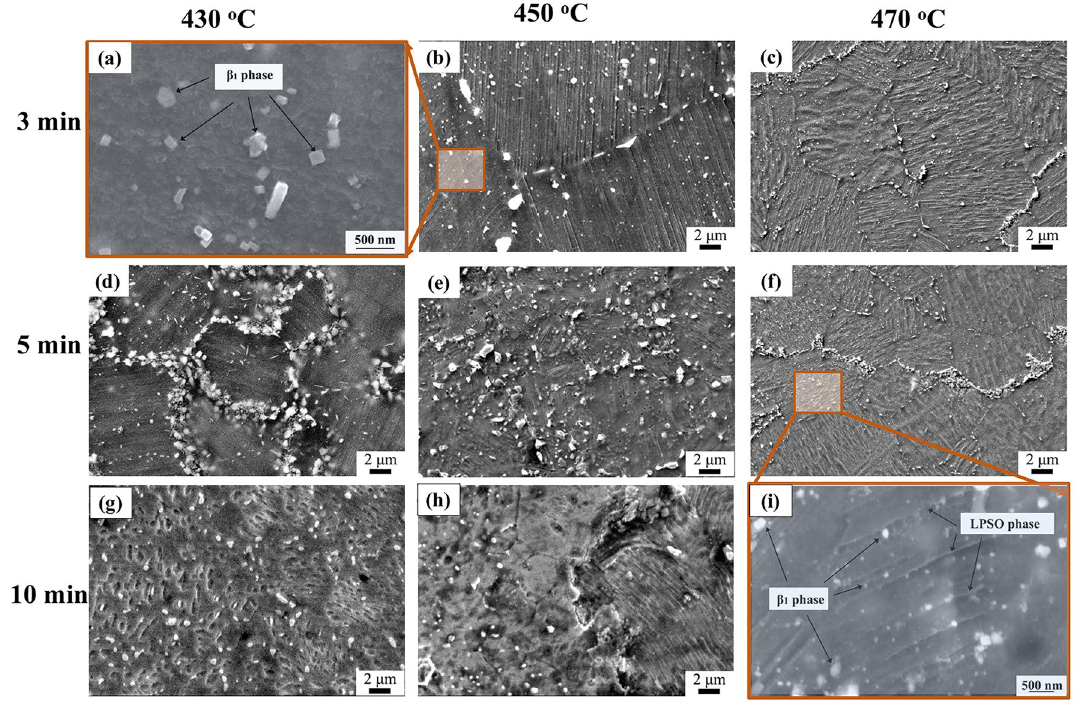
Figure 5. SEM images of sintered Mg–15Gd–1Zn alloy at various sintering times (3–10 min) and temperatures (430–470 °C): ( a–c) for 3 min; ( d–f) for 5 min; ( g–i) for 10 min, each pressure of sintering bulk was 45